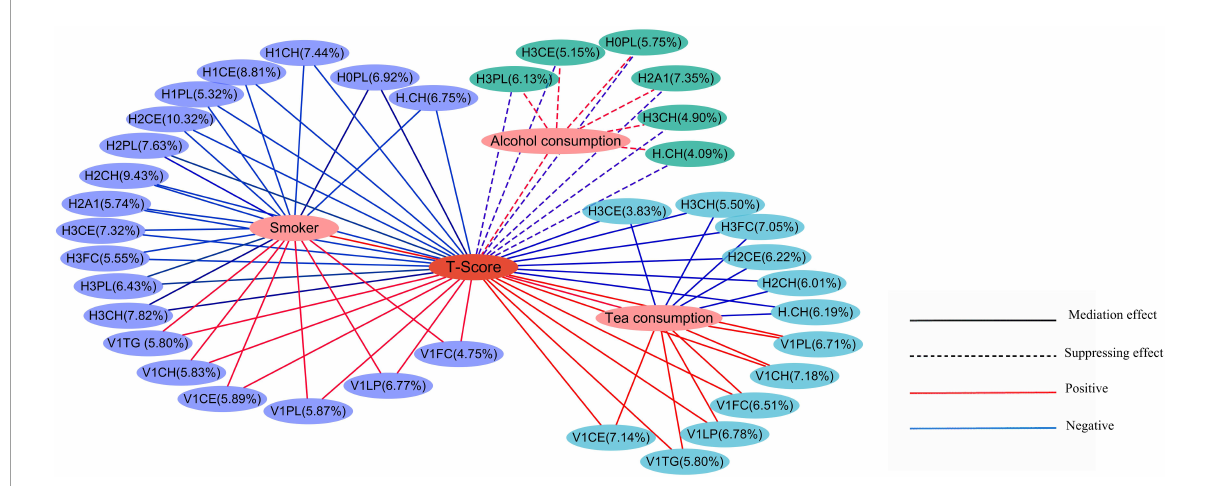
FIGURE3 Mediation effects of lifestyle on T-score through the metabolites. The percentages showed the percentage of the intermediary variable explaining the correlation between the independent variable and the dependent variable. The solid lines represented the mediation effect, while the dashed lines represented the suppressing effects. The red lines represented a positive correlation, and the blue lines represented a negative